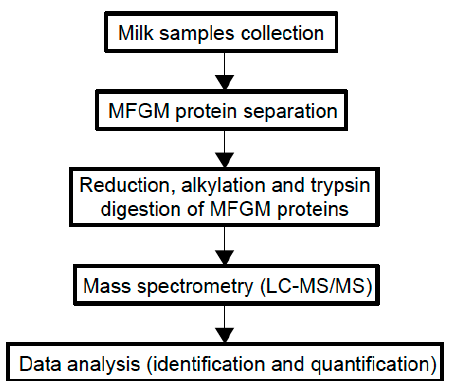
Figure 3. Experimental workflow of MFGM proteome analysis using a proteomic approach.